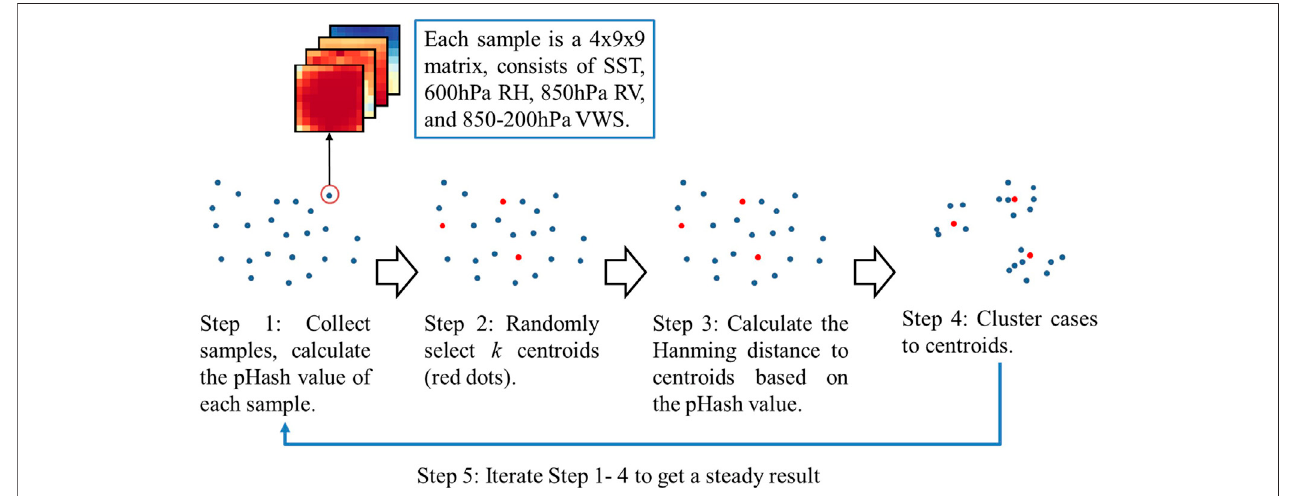
FIGURE 1 | The procedure of the pHash + Kmeans